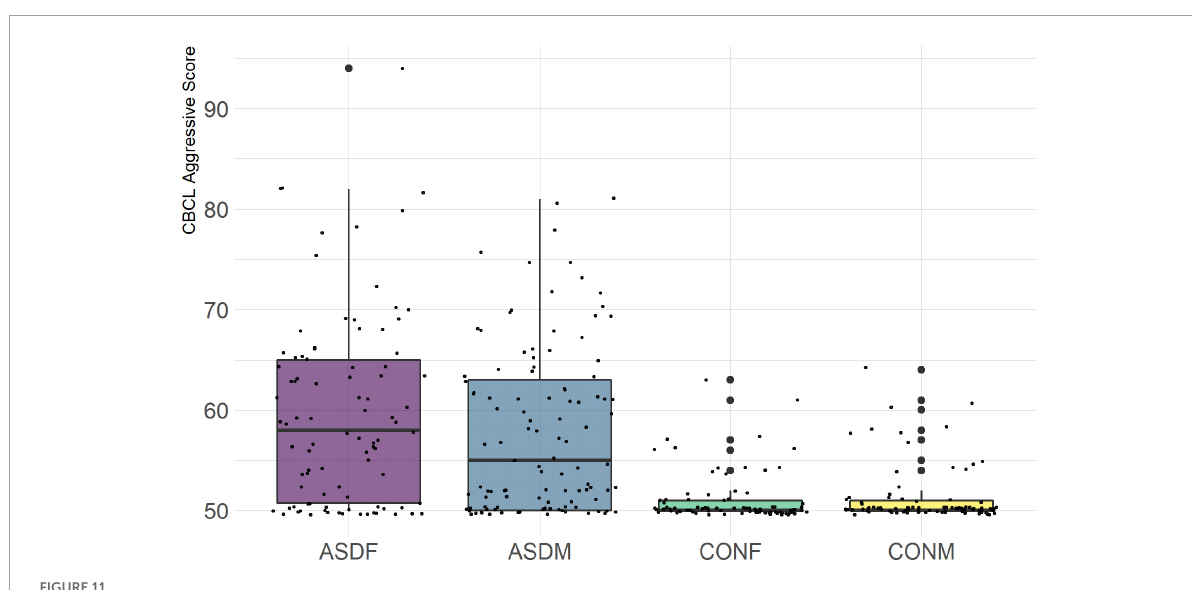
FIGURE11 CBCL Aggressive